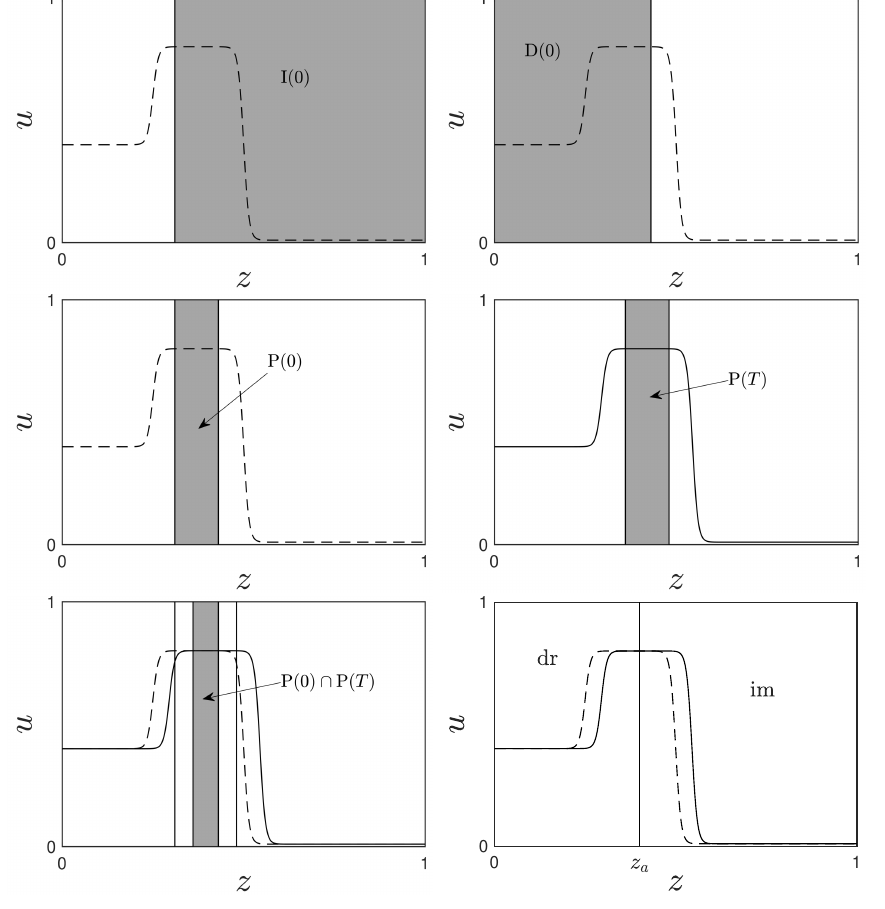
Figure 2. Schematic illustration for the decoupling of the imbibition and drainage fronts. The initial saturation profile u ( z ,0 ) is the dashed line, and the propagated profile u ( z , T ) with T > 0 is shown as a solid line. The top left figure illustrates I ( 0 ) in gray, the top right figure illustrates D ( 0 ) in gray, the middle left figure shows the intersection P ( 0 ) = I ( 0 ) ∩ D ( 0 ) at time t = 0, the middle right figure shows P ( T ) at some time T > 0, and the lower left figure shows P ( 0 ) ∩ P ( T ) . The location z a in the lower right subfigure can be chosen arbitrarily from within the gray interval P ( 0 ) ∩ P ( T ) in the lower left